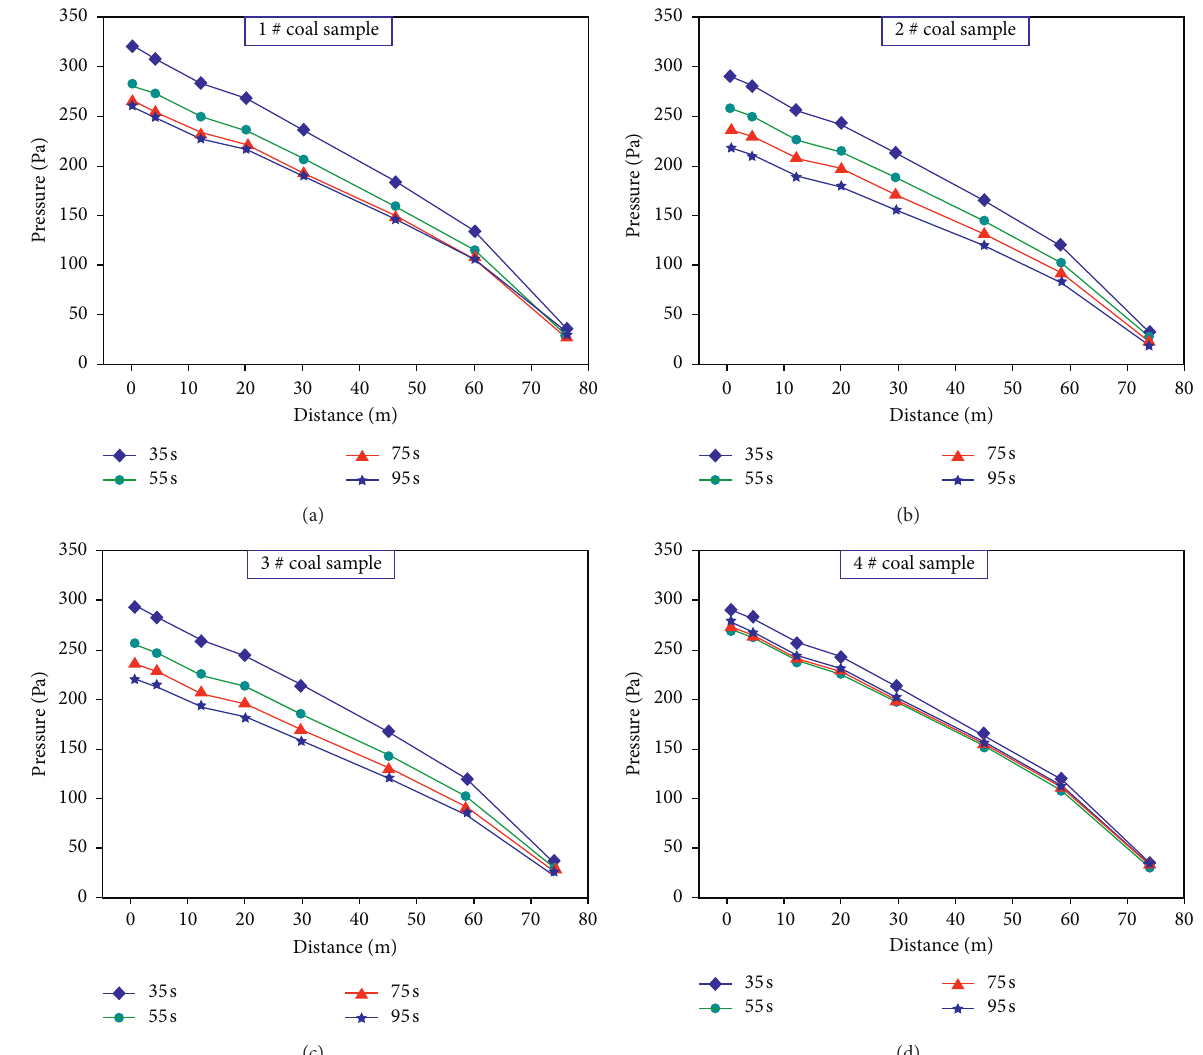
Figure 5: Pressure value in pipeline at different time of stable conveying